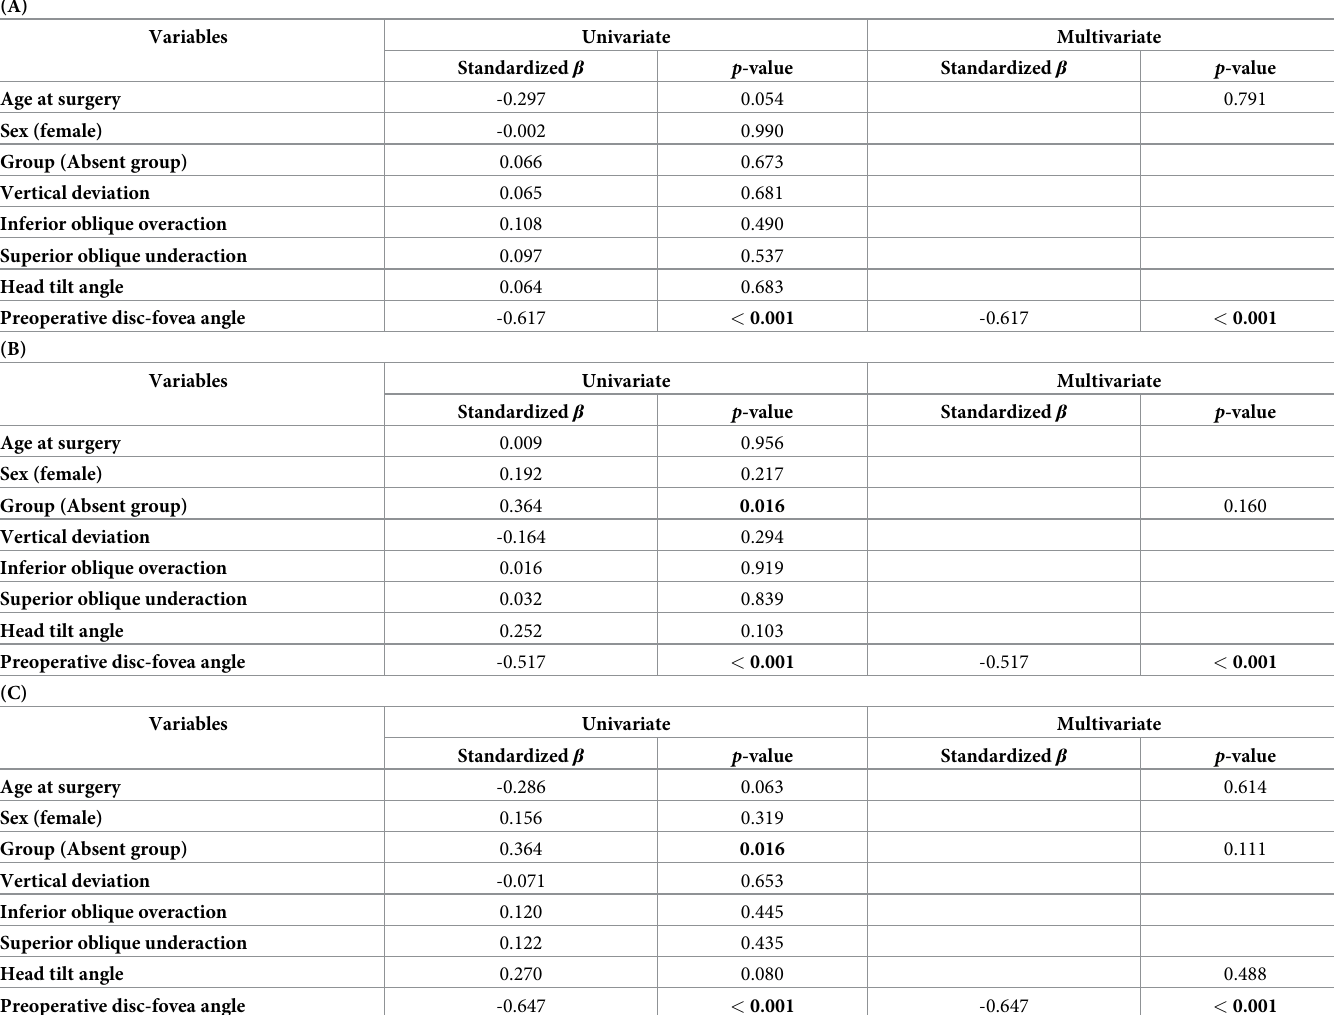
Table 3. Factors associated with the change of the disc-fovea angle after inferior oblique myectomy (A) in the paretic eye, (B) in the non-paretic eye, and (C) in the sum of both